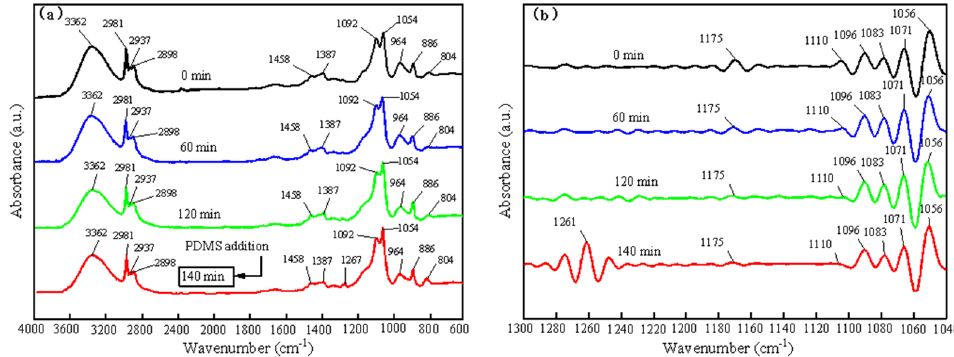
Figure 3. FTIR spectra. ( a ) FTIR spectra of TEOS hydrolysis at 0min, 60 min, 120 min, and 140 min. ( b ) Fourier self-deconvolution infrared spectra of TEOS hydrolysis at 1040 cm − 1 to 1300 cm − 1 for 0 min, 60 min, 120 min, and 140 min.